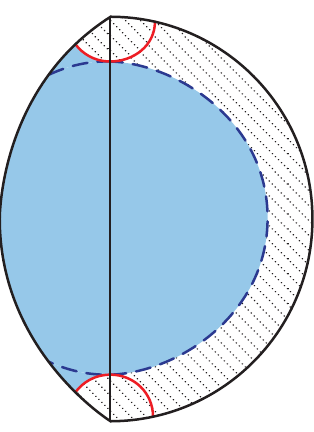
Figure 2. Extension of the cuto(cid:11) surface in the region of the defect following lines of constant r . This generates a cuto(cid:11) surface which is perpendicular to the defect and connects smoothly the two sides. We have indicated in light blue the region inside the cuto(cid:11)